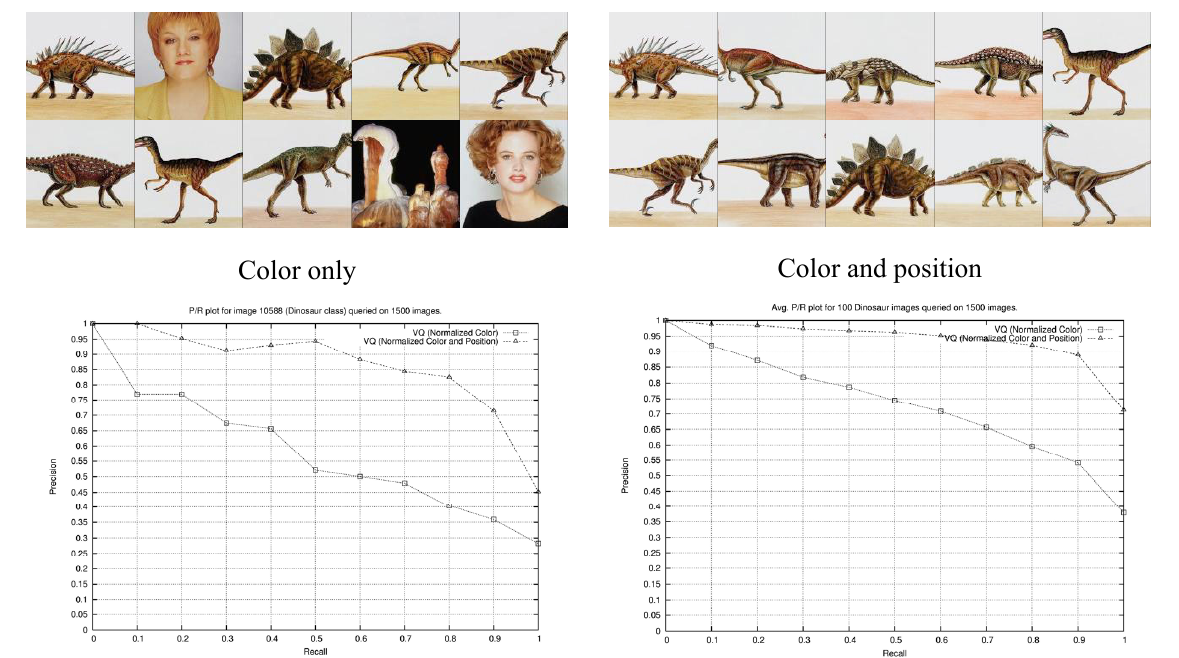
Figure 6. Color vs. color and position.